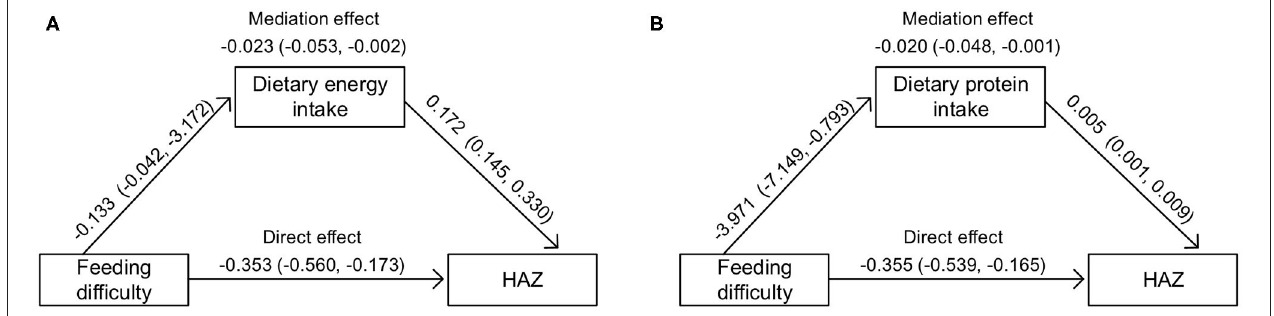
FIGURE 3 | Mediation effects of feeding difficulty through daily intakes of energy [per 1,000 kcal, (A) ] or protein [per g, (B) ] on HAZ. HAZ, height-for-age Z-score. The regressions were adjusted for age, sex, mother’s education level, household economic level, outdoor activity level, place of residence, and birth